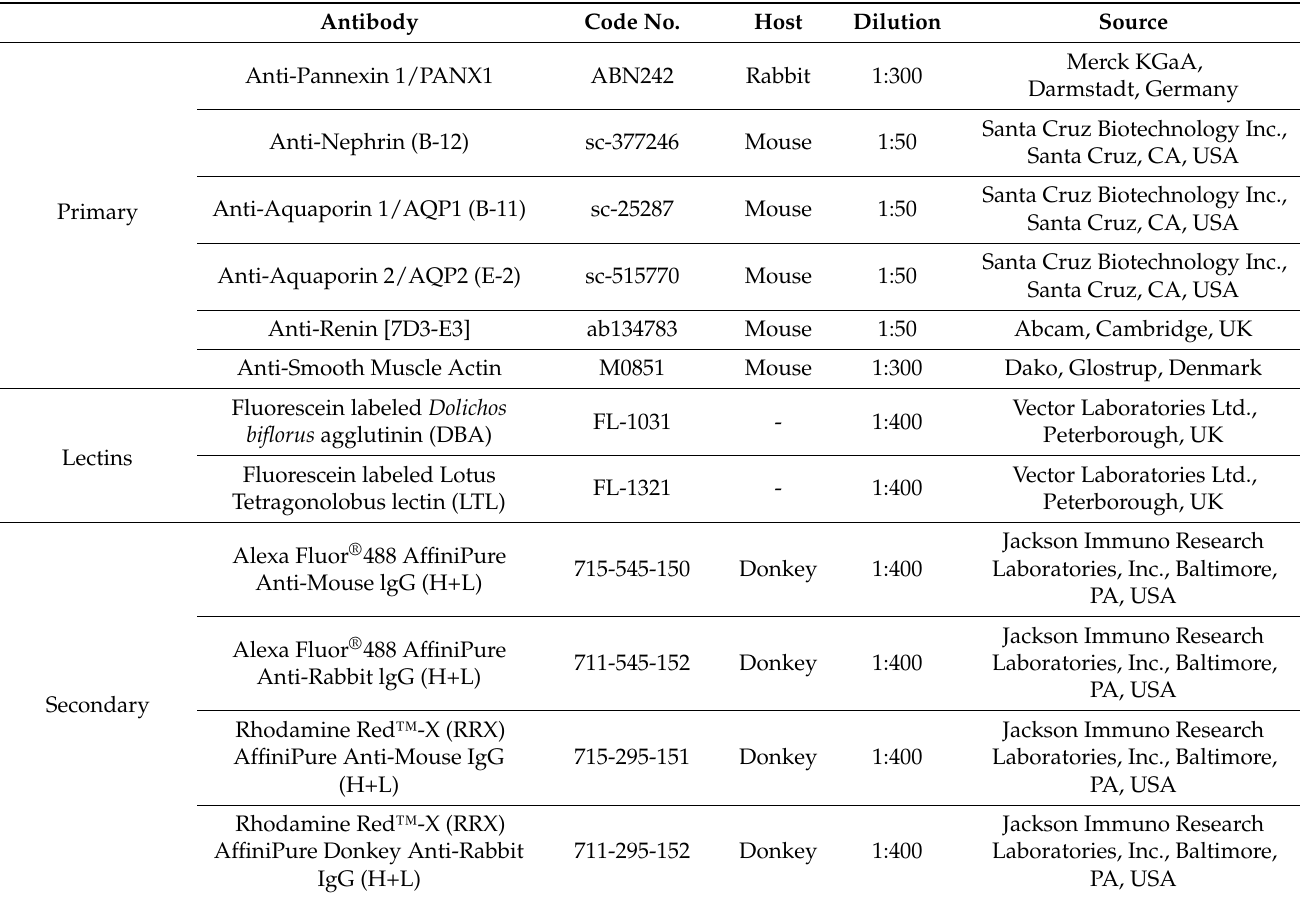
Table 1. Primary and secondary antibodies